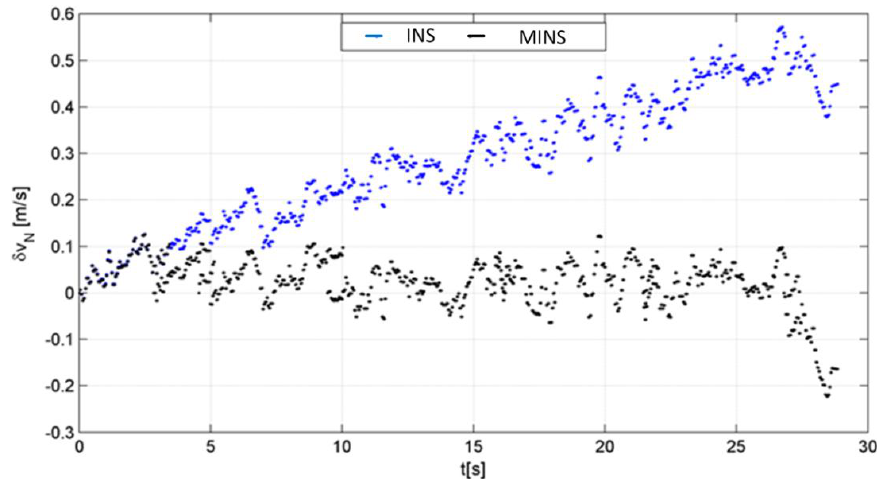
Figure 8. INS (blue) and MINS (black) velocity error with respect to the INS/GPS trajectory, North axis.